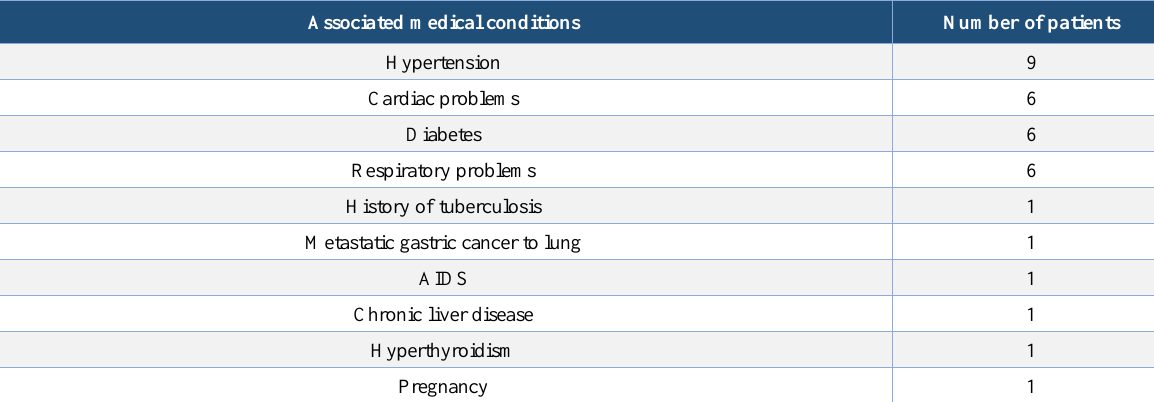
Table 2. Underlying medical conditions in patients underwent COVID-19 real-time PCR test Associated medical